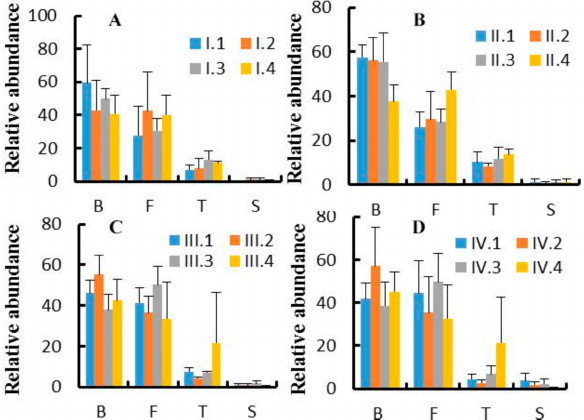
Figure 3. ( A – D ). E ff ects of dietary NFC / NDF ratio change on the relative abundance of phylum bacteria. Figure 3A–D represent experimental periods I (1–18 d), II (19–36 d), III (37–54 d), and IV (55–72 d). Groups 1, 2, 3, and 4 of Karakul sheep were treated with four dietary NFC / NDF ratio of 0.54, 0.96, 1.37, and 1.90. In each graph, B represents Bacteroidetes, F represents Firmicutes, T represents Tenericutes, and S represents